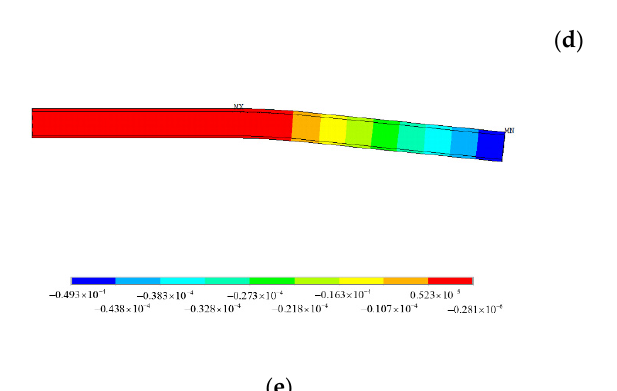
Figure 7. Relationship between voltage and structural displacement: ( a ) End deflection under different voltages; ( b ) structure displacement curve under 1500 V; ( c ) displacement contour map based on piezoelectric simulation under 1500 V; ( d ) displacement contour map based on Bernoulli–Euler model under 1500 V; ( e ) displacement contour map based on the presented method under 1500 V.